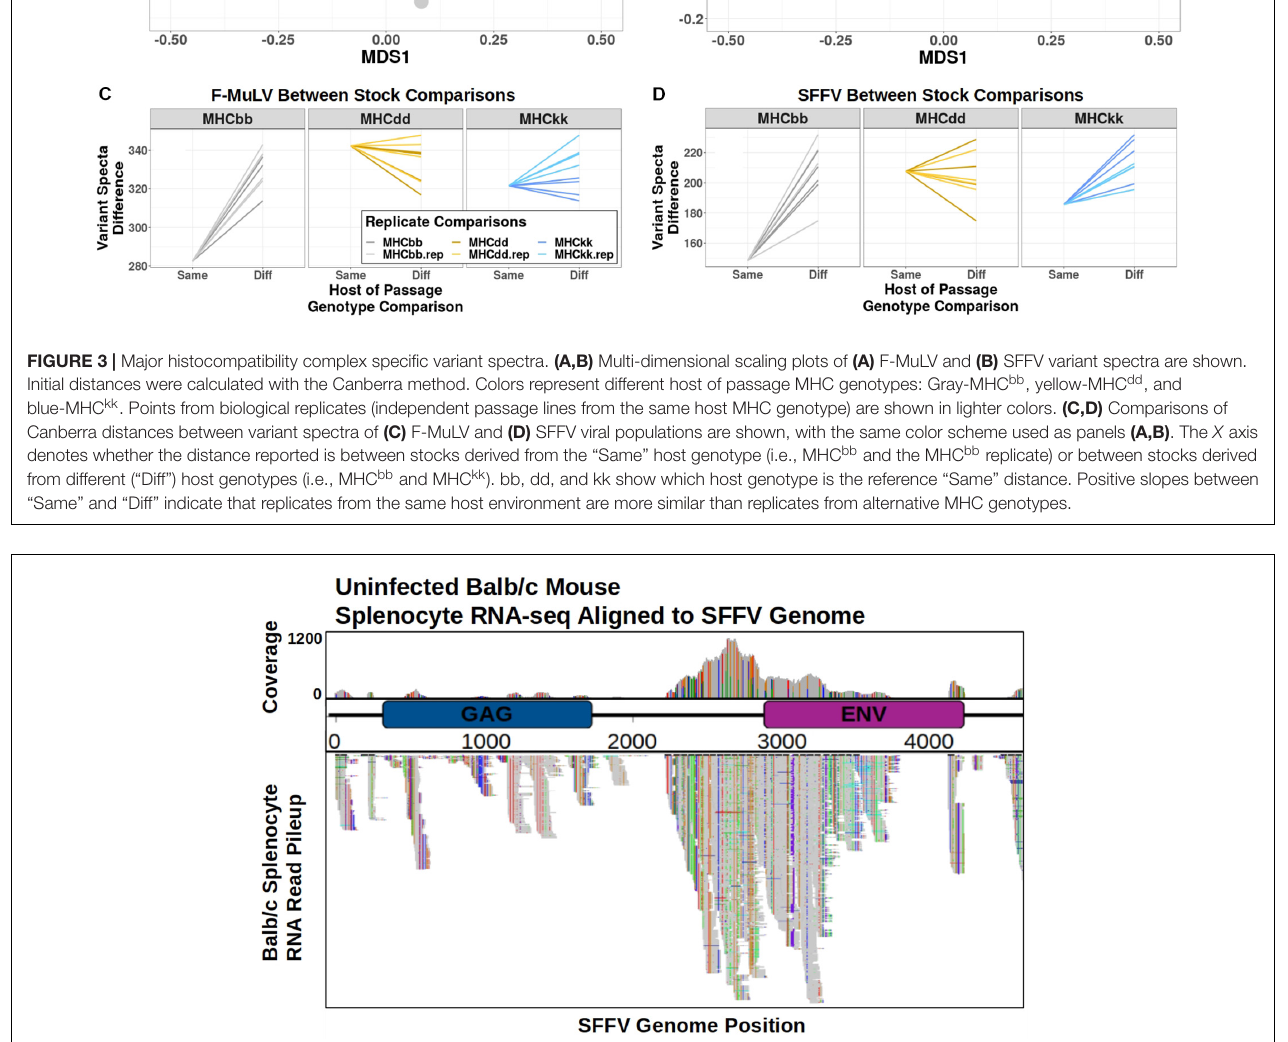
sequence and a representative EnMuLV (chr12:69546811–69 555877 of GRCm39) carrying the majority of ERV-derived SNVs. A custom script was used to assign variants originating